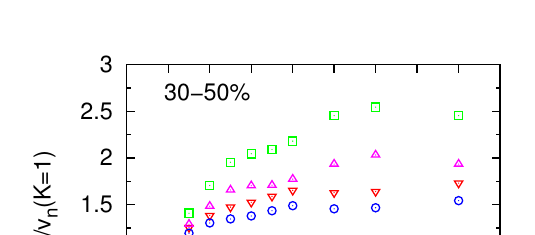
Figure 5. The dependence of the integrated flow harmonics v 2 and v 3 of charm quarks and D mesons on the di ff usion coe ffi cient, tuned by a scaling factor K , which multiplies the scattering cross sections. Here, we focus on a purely collisional energy loss mechanism. The curves are scaled to their respective values at K = 1 to visualize the relative